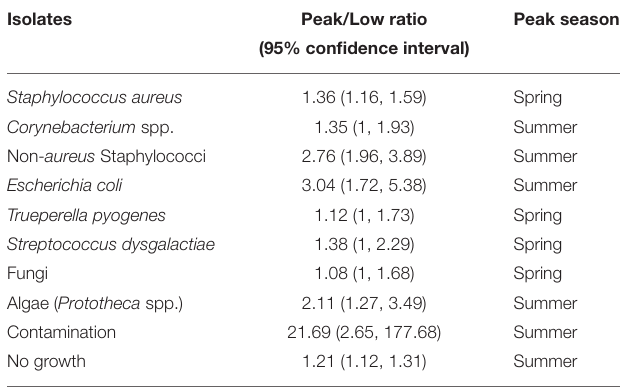
TABLE 10 | Univariable regression analysis of the proportion of samples showing contamination or no growth and those positive for major contagious and environmental mastitis pathogens by location.